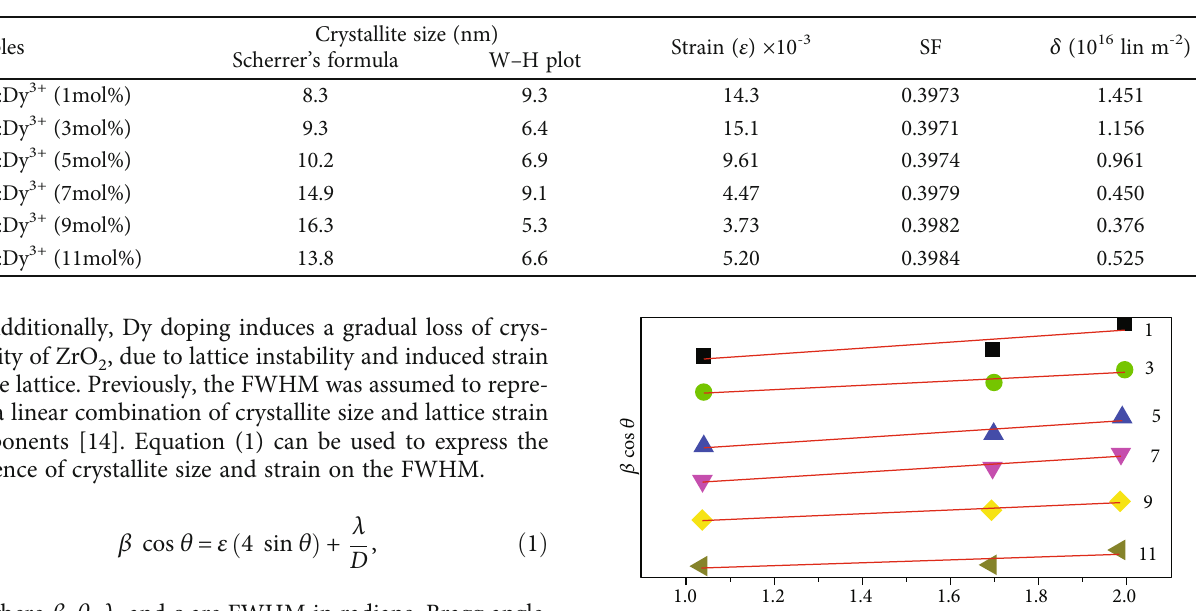
Table 1: Crystallite sizes of ZrO